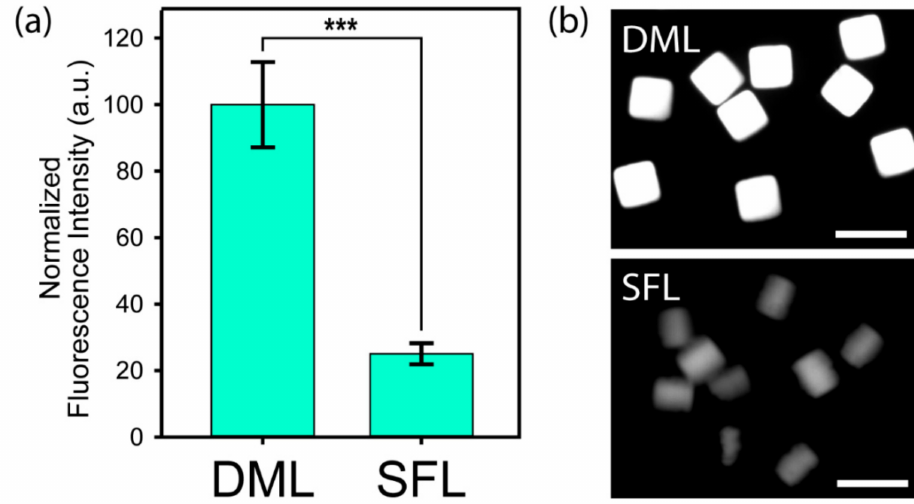
Figure 2. Performance comparison between DML and SFL: ( a ) Normalized fluorescence intensity of Alexa fluor 488 cadaverine conjugated directly to carboxyl groups. Prepolymer composition of 2.5% ( v / v ) PEGDA 700, 62.5% ( v / v ) PEG, 30% ( v / v ) acrylic acid, and 5% ( v / v ) PI was used. *** p < 0.001 compared to the SFL. ( b ) Fluorescence images of synthesized particles through DML ( top ) and SFL ( bottom ). Scale bars are 200 µ